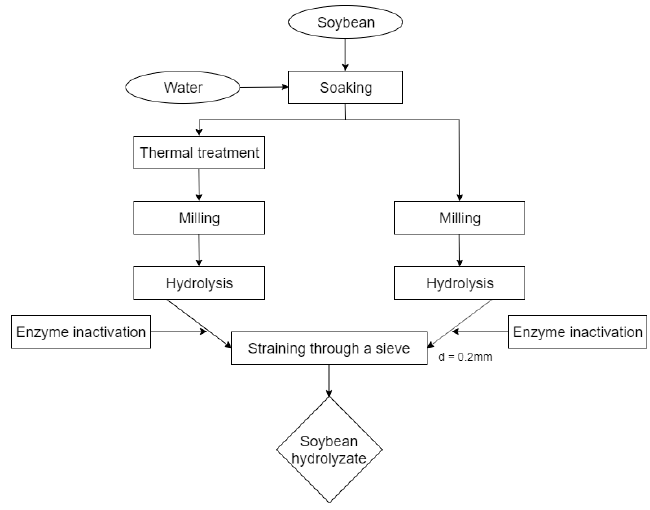
Figure 1. The process of the study.